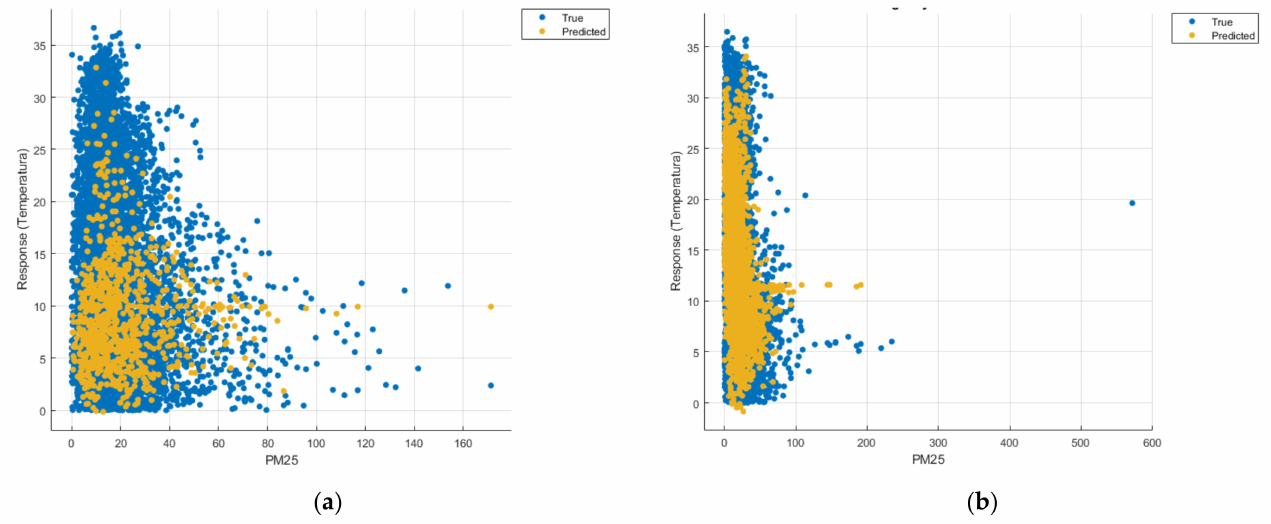
Figure 17. Prediction considering only PM2.5—Fine Gaussian SVM ( a ) March 2019–February 2020, ( b ) March 2020– February